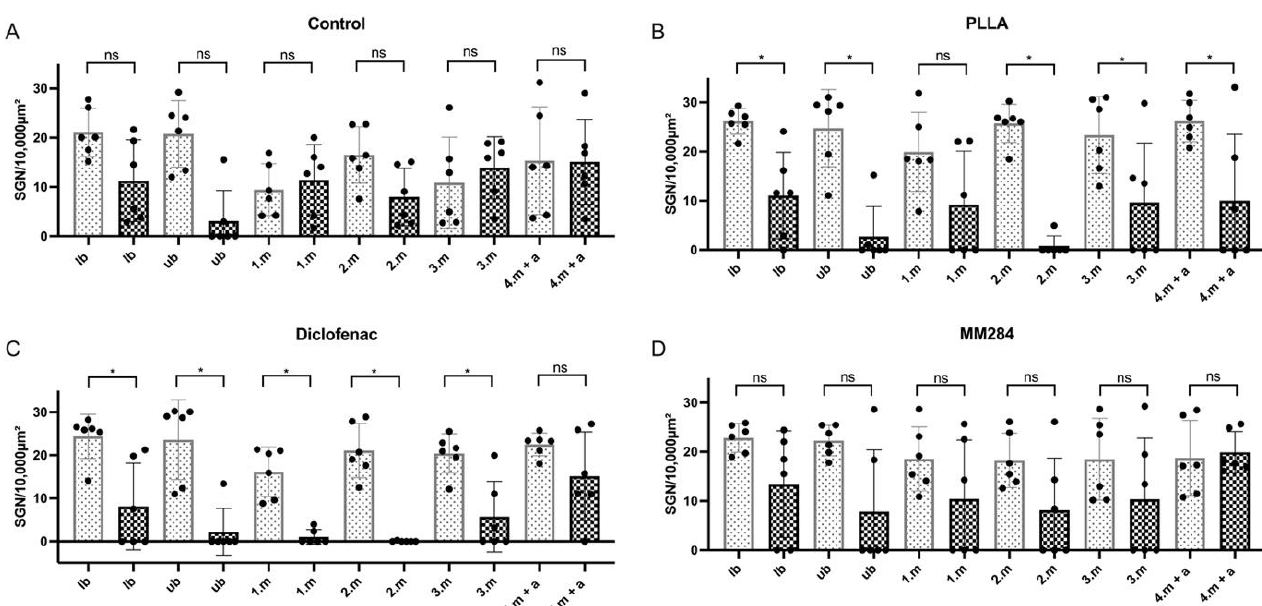
Figure 8. Spiral ganglion neuron density: ( A ) control group, no significant differences; ( B ) PLLA group, significant differences in all turns of the cochlea except the first middle turn; ( C ) diclofenac group, significant differences in all turns of the cochlea except the fourth middle turn; ( D ) MM284 group, no significant differences. Mean ± SD. Light gray dotted bars = right, untreated side; black checkered bars = left, implanted side. * = p < 0.05; ns — not significant.